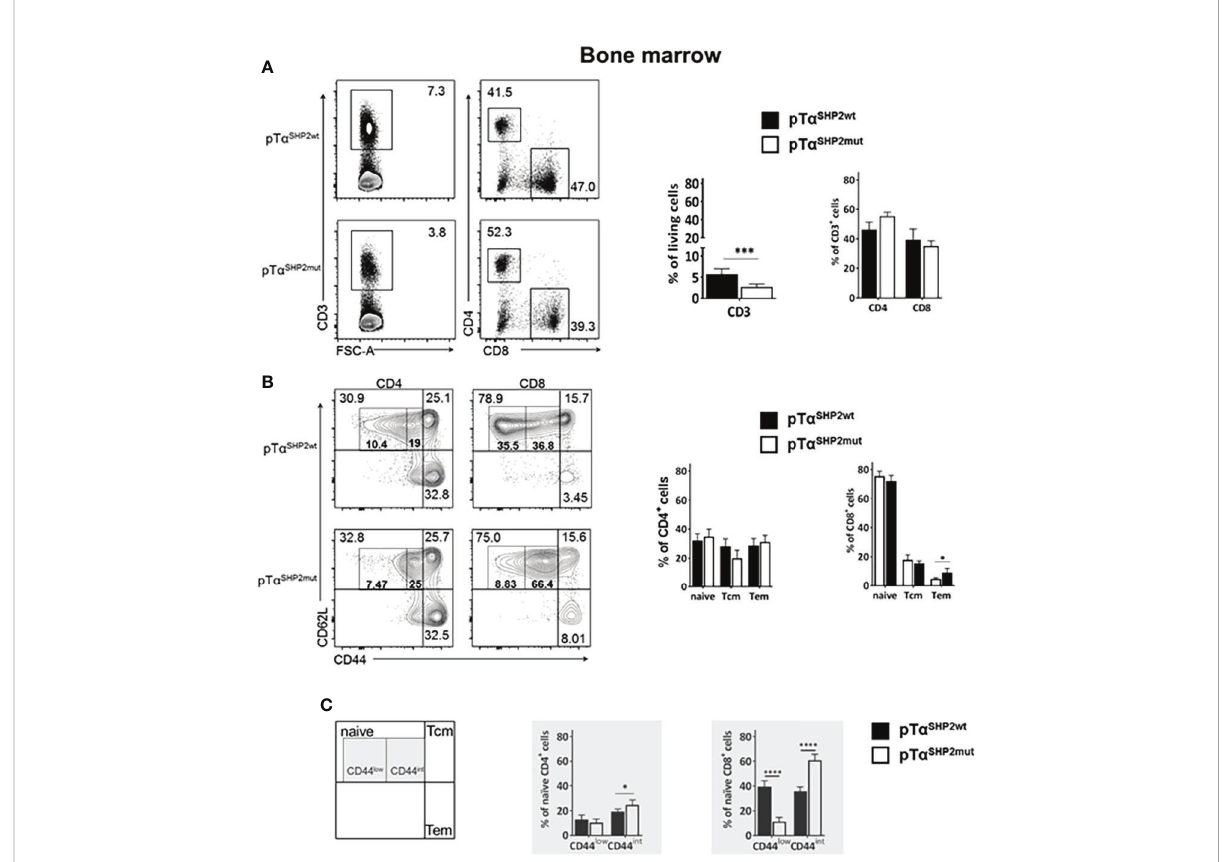
FIGURE 2 Alterations in T cell composition within the bone marrow of SHP2-D61Y mutant mice. Cells isolated from bone marrow of naïve pT a SHP2mut and Cre-control mice were gated on single living cells and used for further FACS analysis. (A) FACS plots and graphs show frequencies of CD3 + T cells within the bone marrow and the CD4:CD8 T cell ratio in pT a SHP2wt and pT a SHP2mut mice. (B) FACS plots and graphs show proportion of naïve, central memory and effector memory T cells in both CD4 + and CD8 + T cell subsets. (C) CD44 low expression in naïve T cells and CD44 intermediate expression in both CD4 + and CD8 + T cells in the bone marrow, marked by grey squares. Data is representative for 2 independent experiments with n=5 mice each. (*p<0.05, ***p<0.001, ****p<0.0001, Student ’ s t-test, mean +